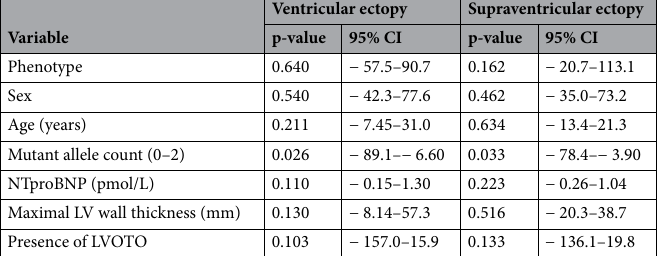
Table 4. Multiple linear regression evaluating for predictors of total ventricular and supraventricular ectopic beats over 48-h Holter recordings.